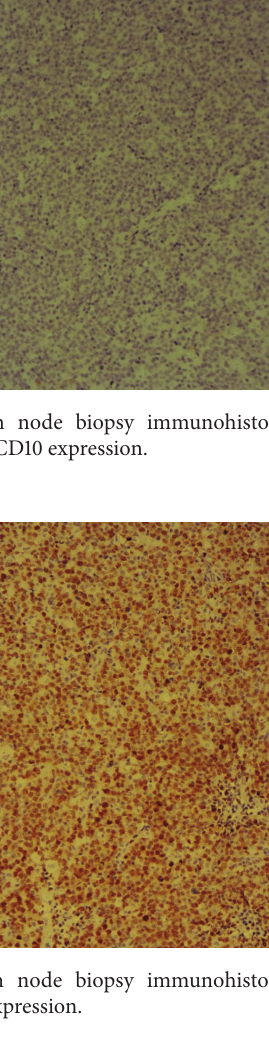
Figure 8: Ki67 immunoperoxidase stain showing positive nuclear staining of the lymphoma cells (Ki67 index ∼ 85%), indicating a high proliferative